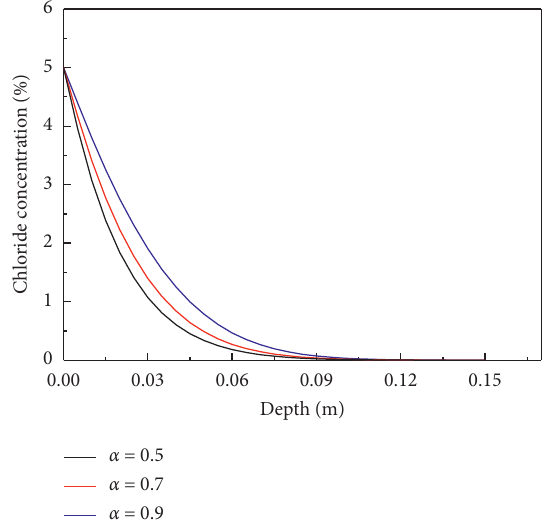
Figure 3: The change of chloride concentration with different α ( t � 20 years).